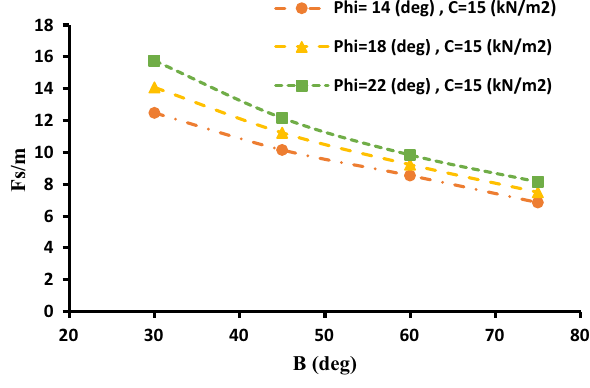
β ) for the state